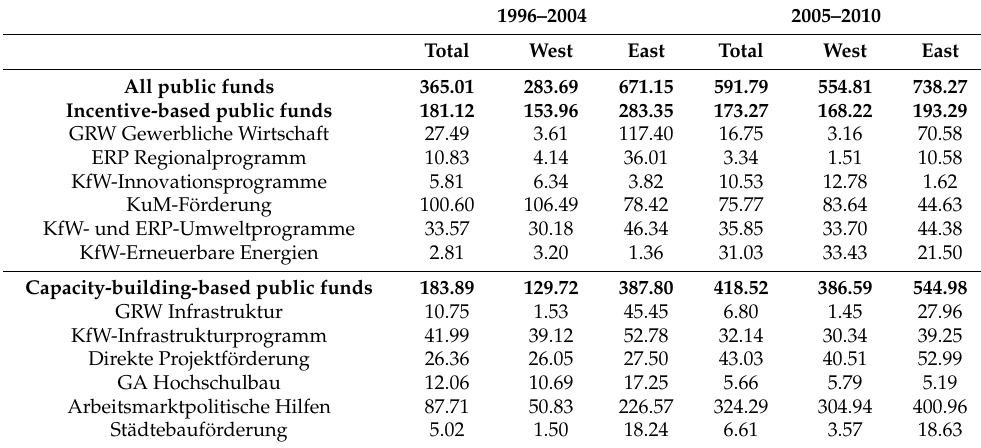
Table 2. Funds with a Potential Impact on Regional Development in Euro per Capita and